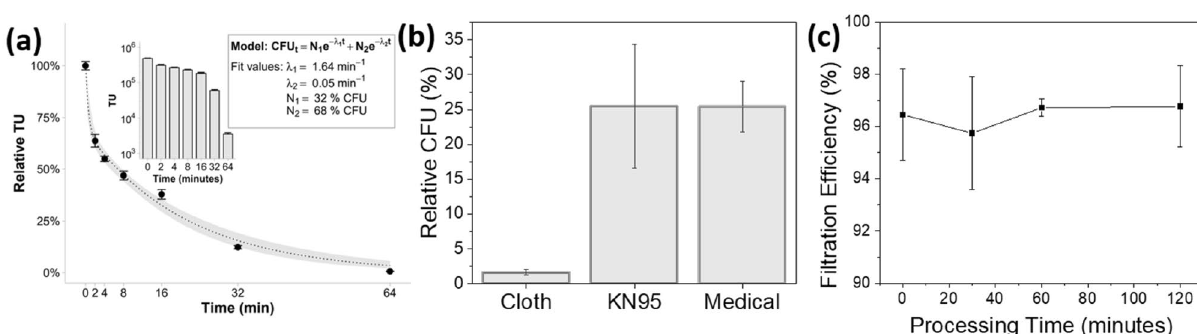
Figure 9. VSV treatment results ( a ) VSV decontamination of surgical masks over time. Each point represents the mean and S.E.M. from three biological replicates that were normalized by the control’s mean TU (mean of control TU was 10 5.68 ). Relative TU were modelled as the sum of two exponential decays. The gray ribbon represents a 95% confidence interval calculated using a parametric bootstrap. After 64 min, we observed a 10 2.13 reduction in TU as illustrated in the inlayed plot. ( b ) Decontamination efficacy after 30 min using low-cost system on different mask types. ( c ) Filtration efficiency of KN95 masks as a function of treatment time. No significant changes in filtration was